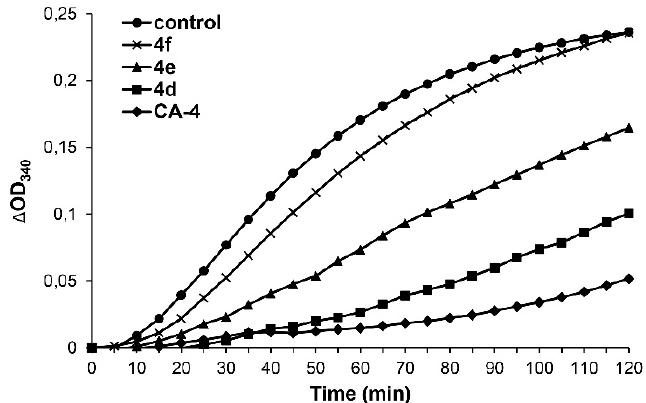
Figure 2. Effects of compounds 4d–f and CA-4 (10 µM) on the polymerization of tubulin as determined by a turbidimetric cell-free tubulin assay. Data are representative of three independent experiments. Δ OD 340 is the change in the absorption at 340 nm wavelength with OD 340 set as 0 at 0 min ( p ≤ 0.001 for CA-4 and 4d compared to controls, one-tailed Dunnett post-hoc test).